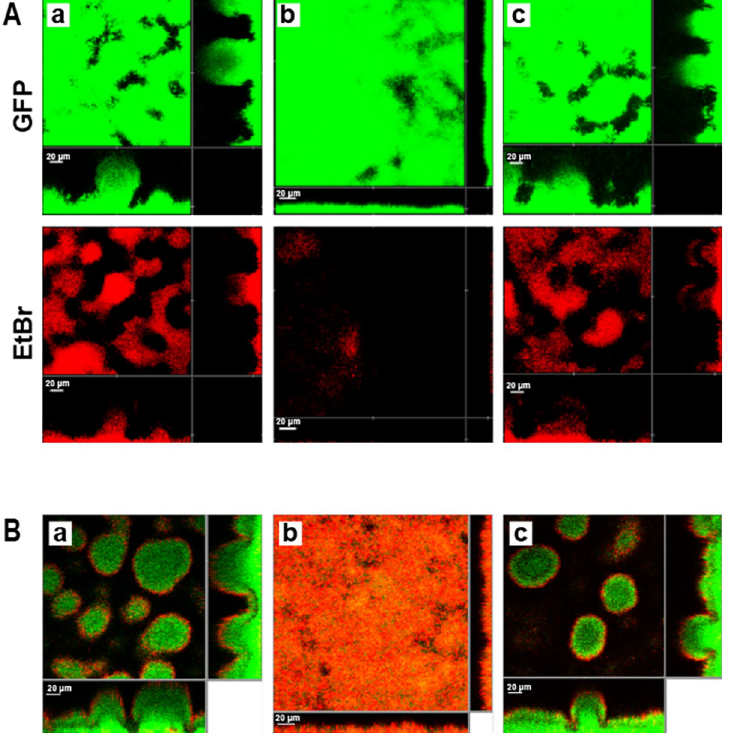
Fig 3. P . aeruginosa tat mutants form defective biofilms with increased susceptibility to tobramycin. CLSM images showing four-day-old biofilms formed in flow chambers of the gfp -tagged P . aeruginosa wild-type (a), tatA mutant (b) and genetically complemented tatA mutant (c). In (A) biofilms were stained for total biomass with Syto9 (green) and for eDNA with ethidium bromide (red). In (B) biofilms were treated with tobramycin and the medium was supplemented with propidium iodide prior to CLSM such that dead cells appear red while live cells appear green. Each panel shows one horizontal optical section two flanking vertical optical sections. Bars, 20 μ m.